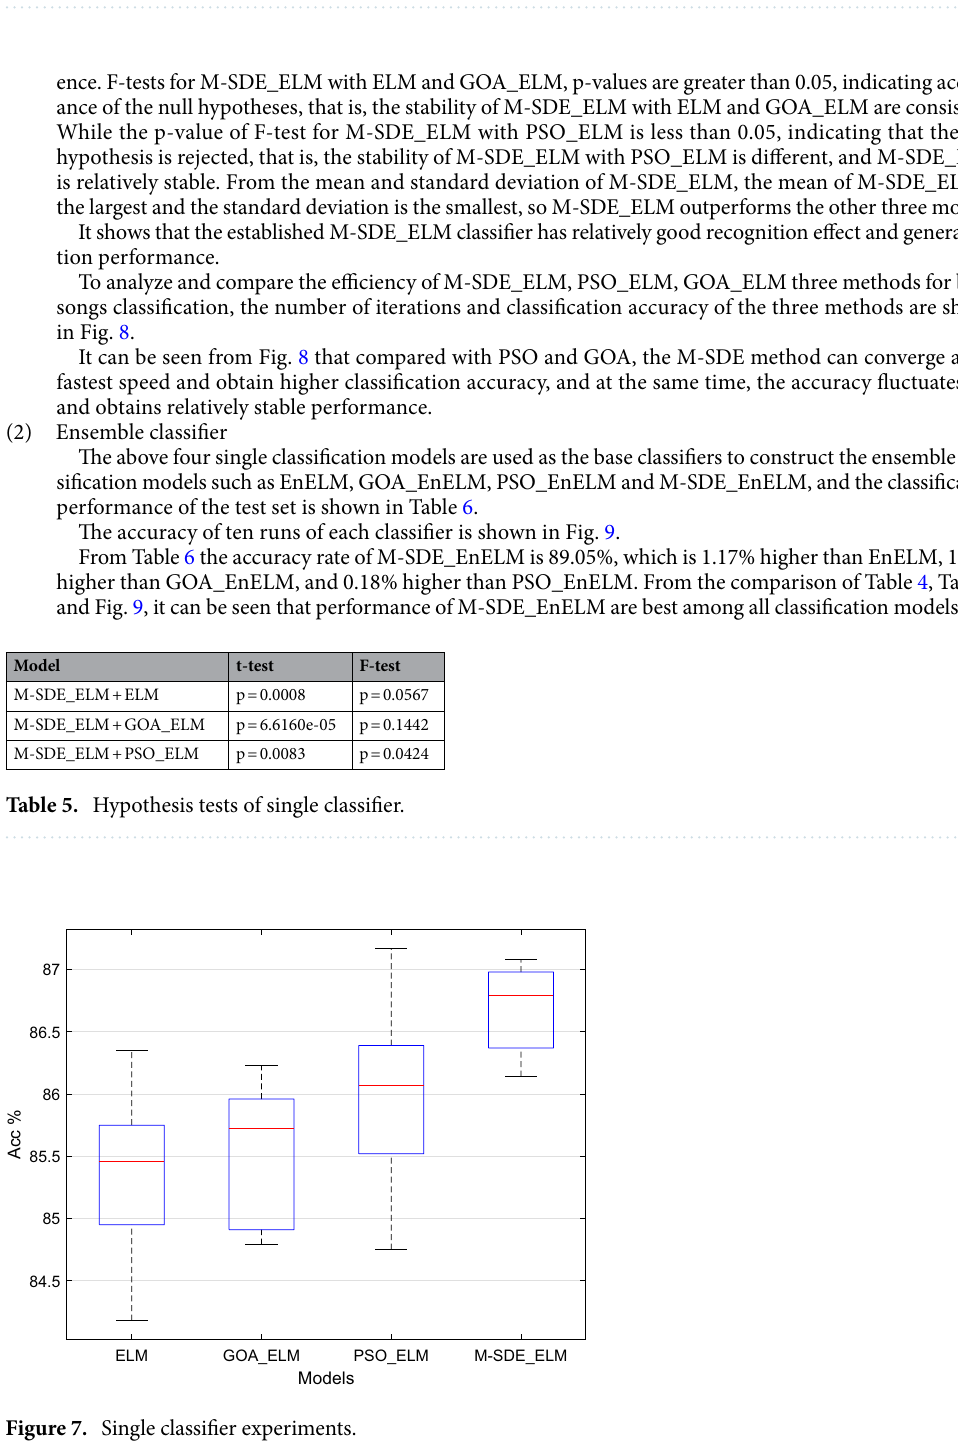
Table 4. Performance of single classifier.